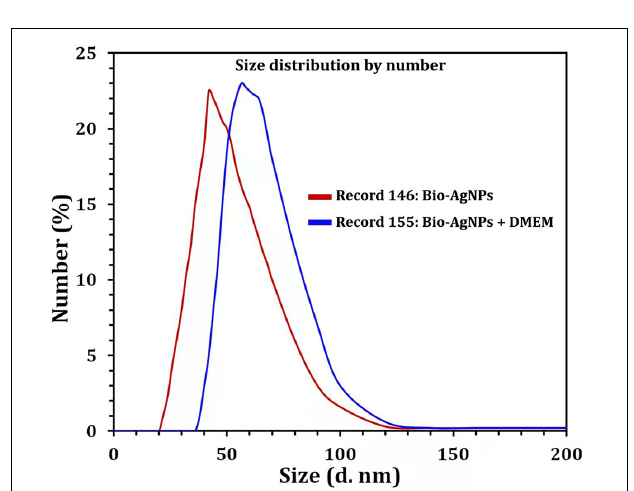
FIGURE 9 | Size distribution by number graph of Bio-AgNPs. In aqueous solution (red line), in DMEM culture medium (blue line) as revealed by DLS.